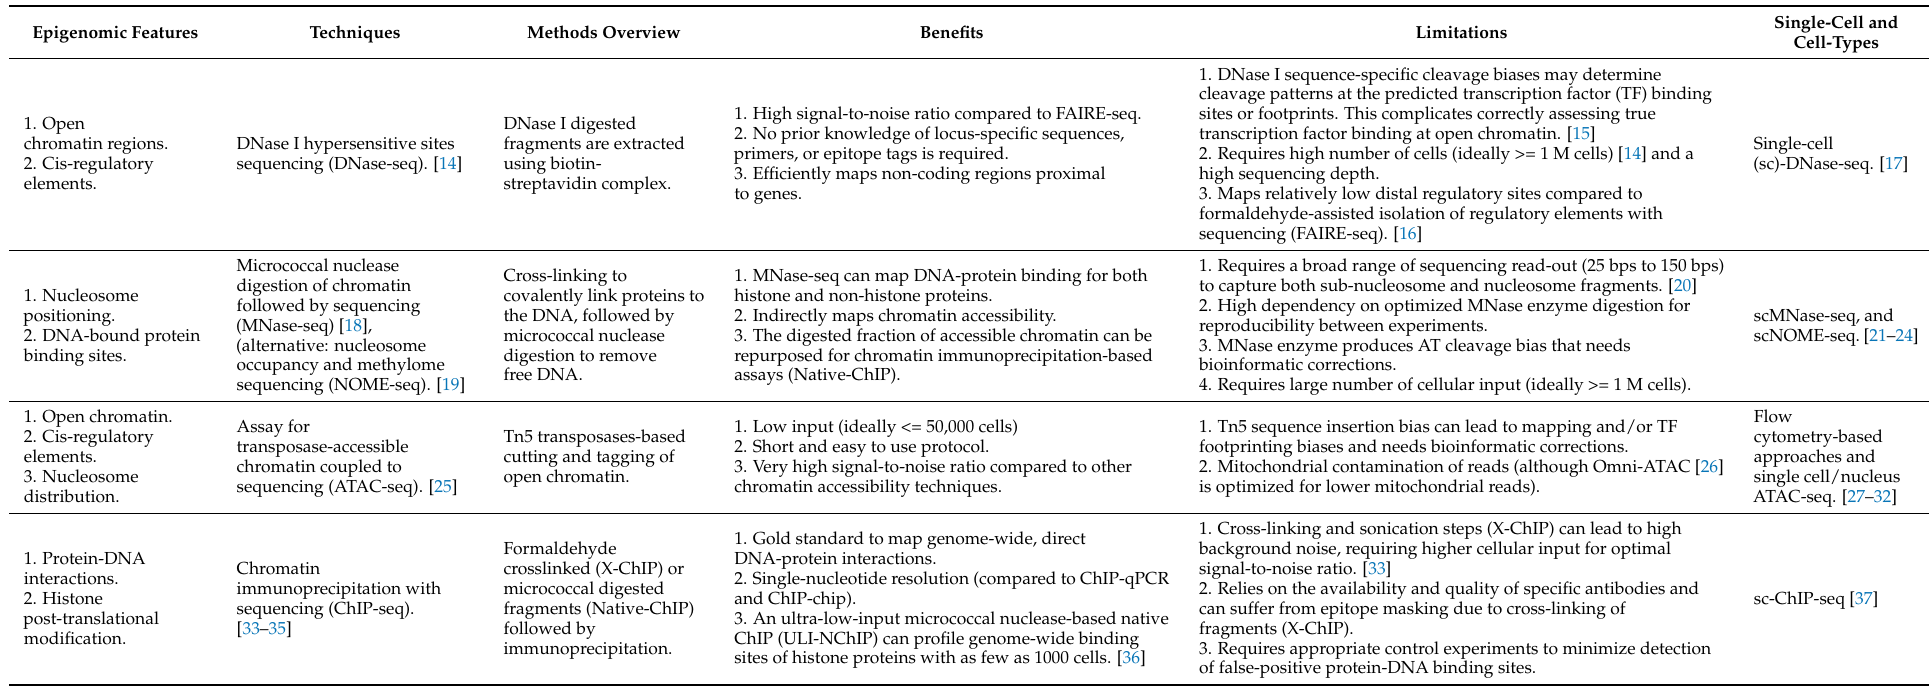
Table 1. Comparison of chromatin profiling techniques to assaying epigenomic